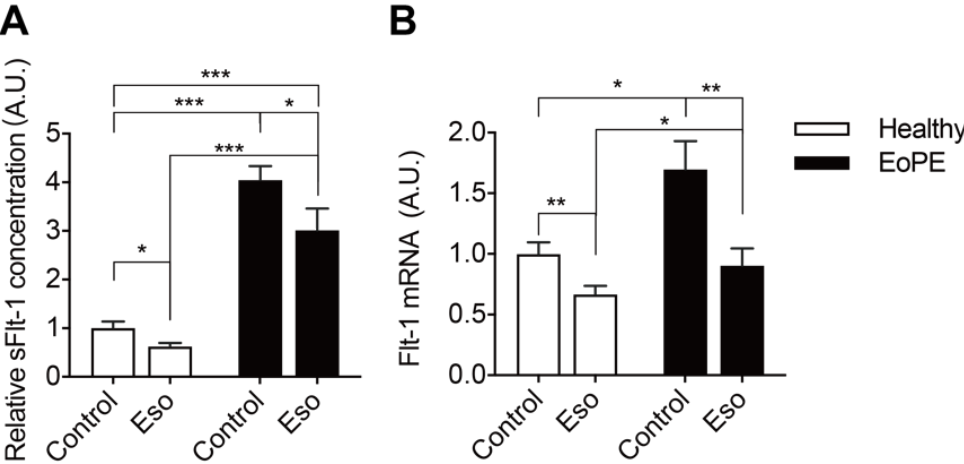
Figure 5. sFlt-1 levels in medium ( A ) and mRNA levels in explants ( B ) after incubating healthy or pre-eclamptic (EoPE) placental villous explants with 100 µ M of esomeprazole (Eso) for 48 h. sFlt-1 level: healthy n = 18, EoPE n = 8; Flt-1 mRNA level: healthy n = 7, EoPE n = 4. * p < 0.05, ** p < 0.005, *** p < 0.0005 vs. 0. A.U., arbitrary unit.